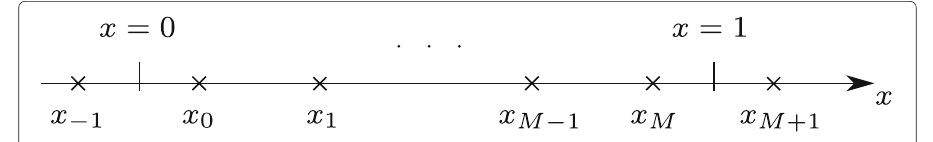
Fig. 5 The computational domain ( 0,1 ) . Set x 0 = h / 2 and x M = 1 − h / 2. Then x − 1 = − h / 2 and x M + 1 = 1 + h / 2 are ghost